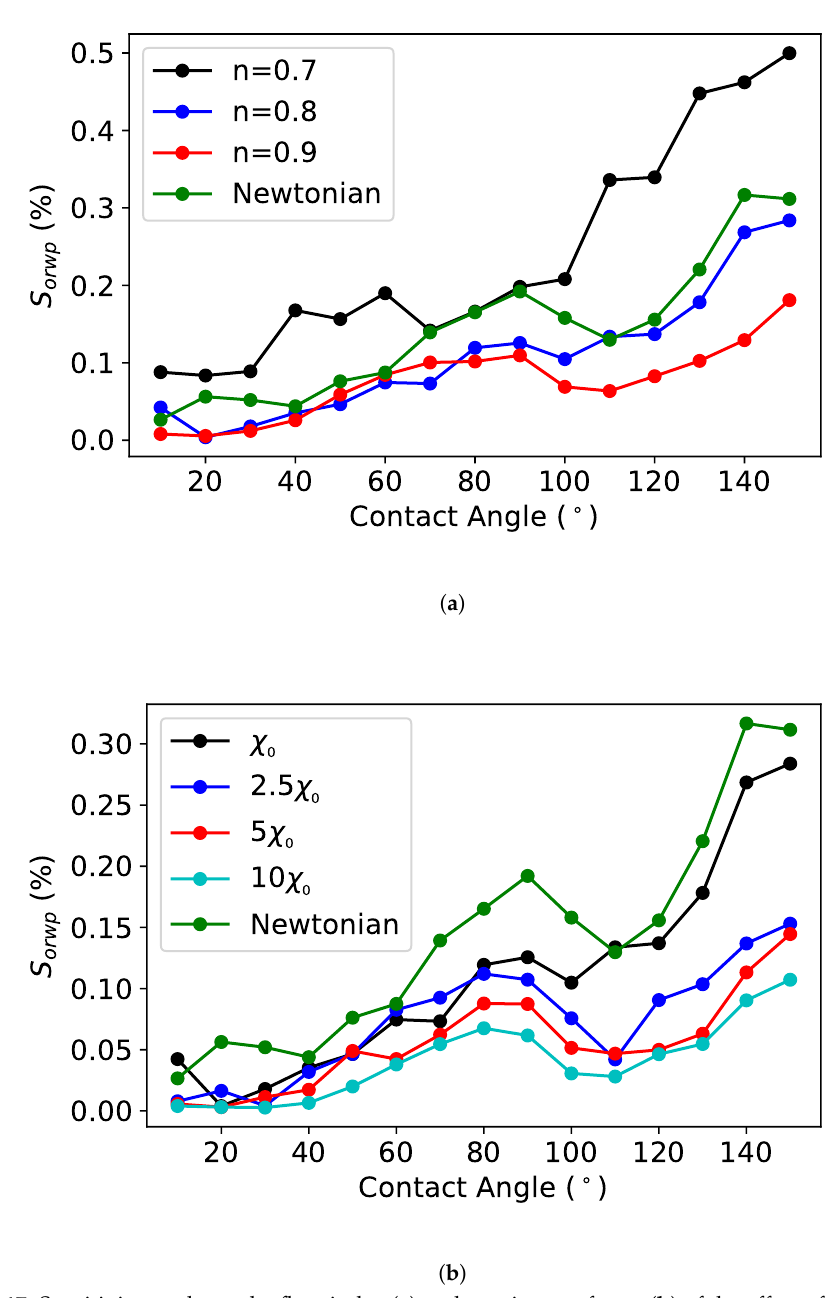
Figure 17. Sensitivity study on the flow index ( a ) and consistency factor ( b ) of the effect of the wettability on S or for a non-Newtonian